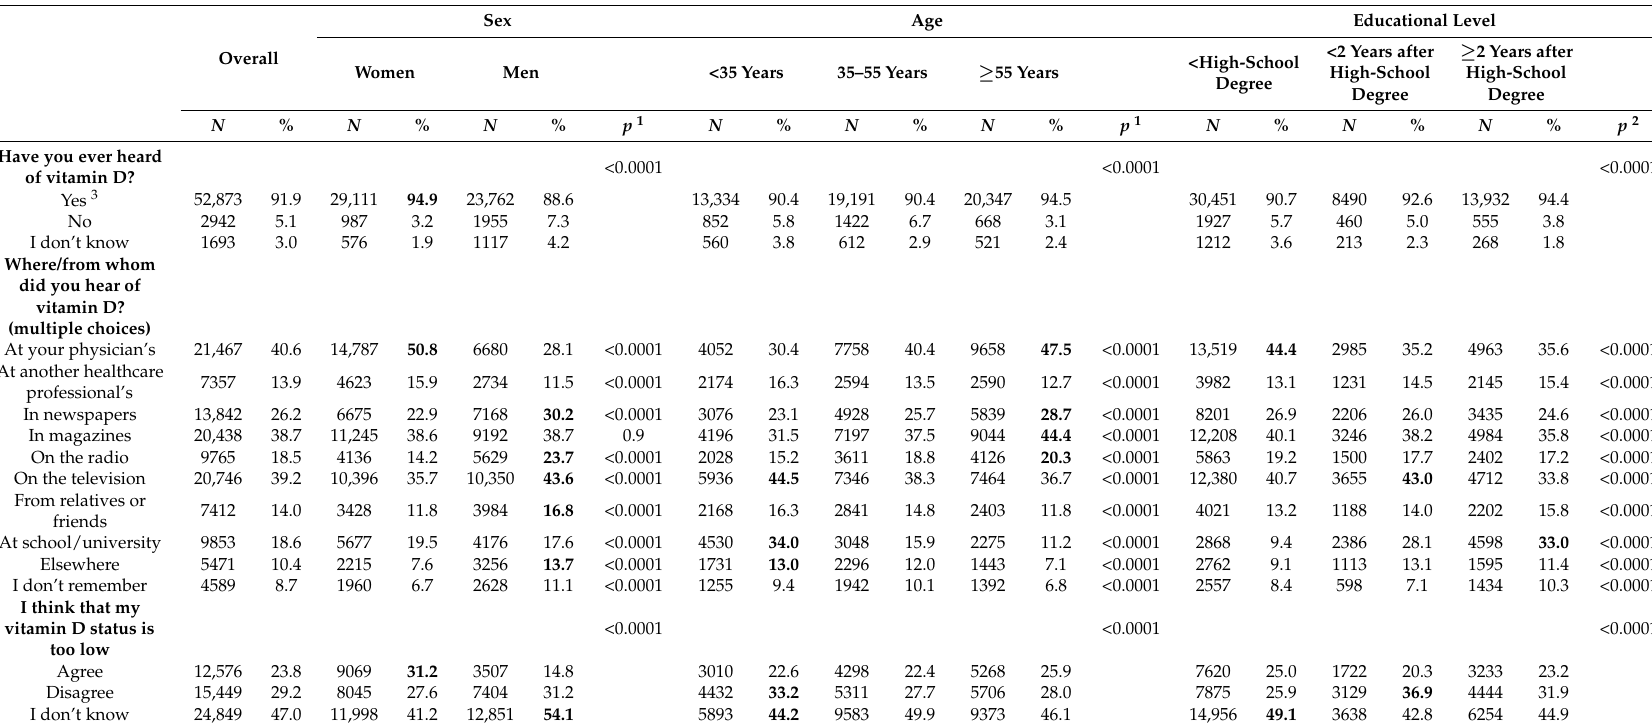
Table 2. Sources of information regarding vitamin D and concerns regarding vitamin D status overall and according to age, sex and educational level, NutriNet-Santé cohort, France